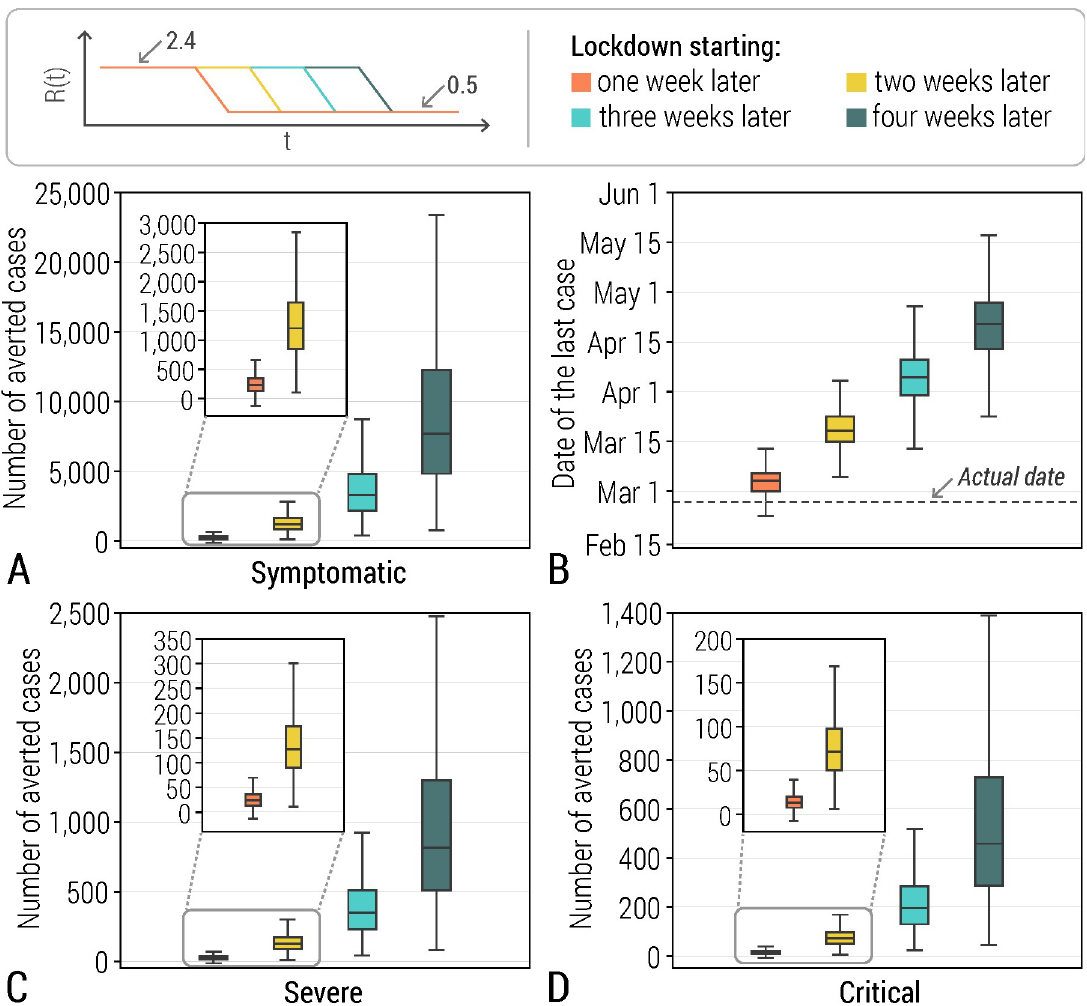
Fig 3. A Estimated number of averted symptomatic cases (min, quantile 0.25, median, quantile 0.75, max), should the public health declaration have occurred one to four weeks later. Estimates are obtained by considering R 0 = 2.4 (95% CI: 1.6–3.7) and R final = 0.47 (95% CI: 0.4–0.54); R(t) is assumed to follow a 1-week linear decrease from R 0 to R final . R final was estimated over the period from February 1 (i.e., one week after the declaration of the emergency) to the end of the outbreak. B Same as A, but for the date of the last case of the simulated epidemics. C Same as A, but for severe cases. D Same as B, but for critical